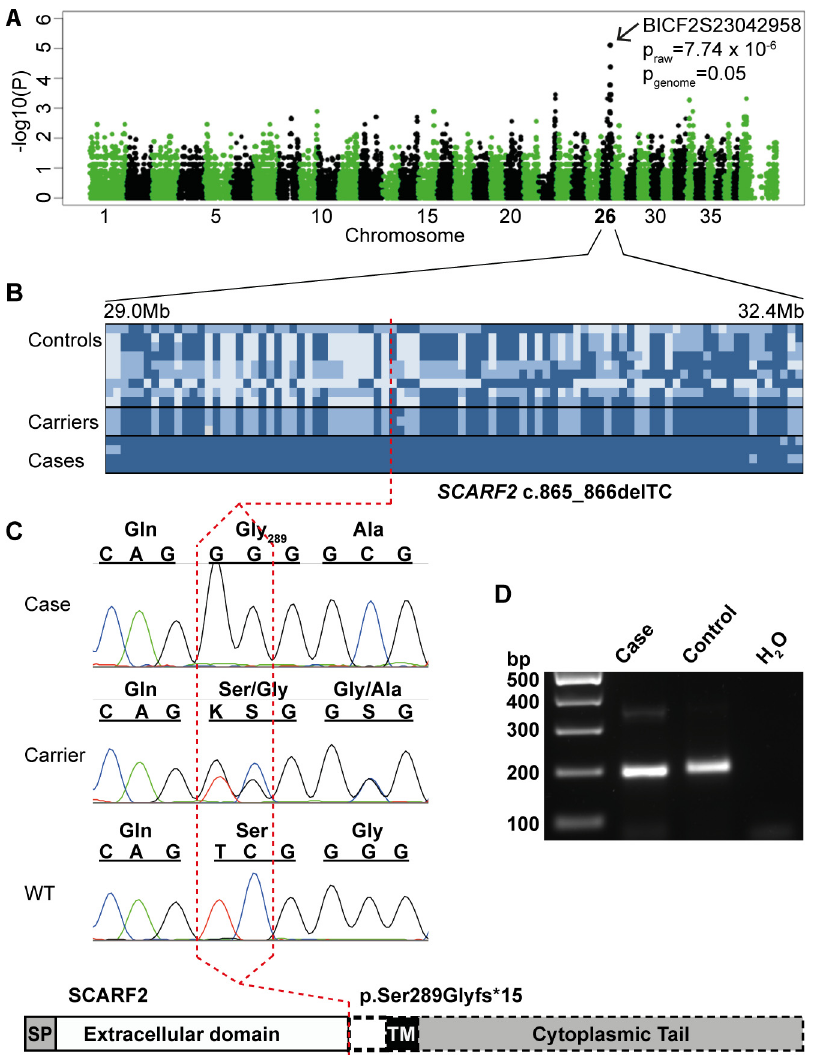
Fig 3. Genetic analyses in a developmental syndrome in Wire Fox Terriers reveal a deletion in exon 6 of SCARF2 , resulting in an early truncation of the predicted protein. A . A Manhattan plot from a GWAS indicates a locus on chromosome 26 (p genome = 0.05). B . A 3.3-Mb disease-associated haplotype in the affected dogs. C . Targeted resequencing revealed a 2-bp deletion in exon 6 (c.865-866delTC), resulting in a severe truncation at Ser289 that removes the transmembrane and cytoplasmic domains of the predicted protein as indicated by a dashed line in the schematic structure. D . RT-PCR in the affected and control Wire Fox Terrier indicate expression of SCARF2 mRNA and suggest that the mutated SCARF2 transcript is not directed to nonsense-mediated RNA decay.